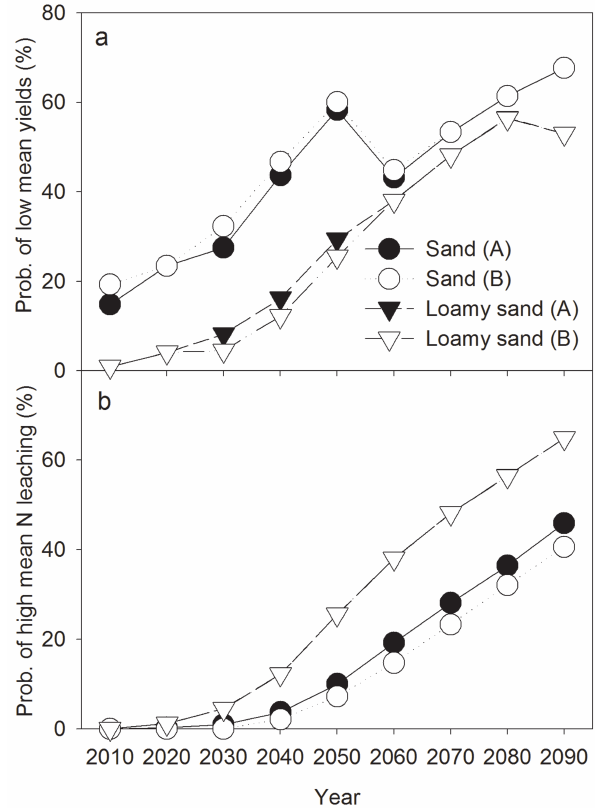
Fig. 6. Probability of mean yield reduction larger than 20% com- pared to yield simulated for baseline and probability of mean N leaching exceeding threshold levels of 50kgNha − 1 for loamy sand and 70kgNha − 1 for sandy soils. Results were calculated for pro- jected climate conditions at 10-yr intervals during the 21st century for the A1B emission scenario using methodologies A and